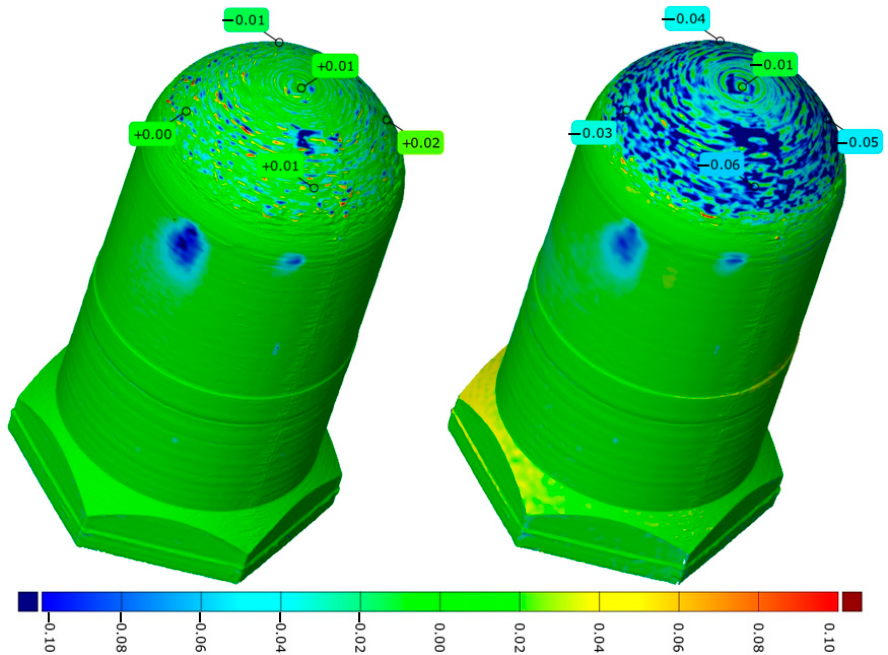
Figure 14. Wear of punch in Test 4_S between 5 ( left ) and 100 pieces ( right ). All values are in mm unit. Table 18. Wear of punch in Test 4_S between 5 and 100 pieces, measured values at given points. Test 4_FE_1 Wear Measurement Results Measurement